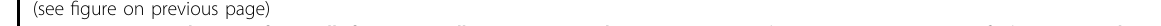
Fig. 2 Stepwise induction of iNK cells from LPM cells using organoid system. a Organoid aggregate images at speci fi ed time points. b Immuno- phenotypes of hemogenic endothelial cells (iHECs, de fi ned as CD73 – DLL4 + CD31 + CD34 + CD144 + ) on Day 9. c Immuno-phenotypes of hematopoietic progenitor cells (iHPCs, de fi ned as CD235a – CD45 + CD34 + CD43 + ) on Day 16. d Immuno-phenotypes of iNK cells (CD45 + CD3 – CD56 + CD16 + / – ) on Day 27. e The images of NK cells separated from organoid aggregates on Day 27. f The dynamic quantities of iNK cells (CD45 + CD3 – CD56 + ) at the indicated time points ( n = 3 each group). g Statistics of yields of iNK cells (Day 27) induced from different hPSC lines. n = 4 each group. Data were collected from four batches of induction experiments using fi ve human ESC lines (hPSC-1, hPSC-2, hPSC-3, hPSC-4, and hPSC-5) and one iPSC line (hPSC-6). One point represents the mean of iNK cell output from three repeats per batch induction experiment. h The residual OP9 feeder cells at the selected time points ( n = 3 each group). Two-tailed independent t -test. Mann-Whitney U test ( f ), and one-way ANOVA ( g